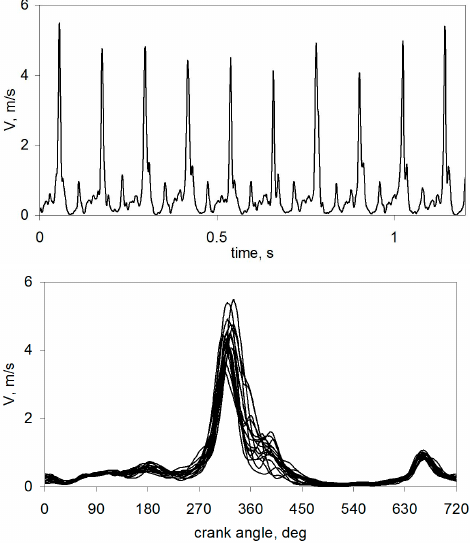
Figure 1. Speeds of the fresh charge in the combustion chamber of the SI engine [36].